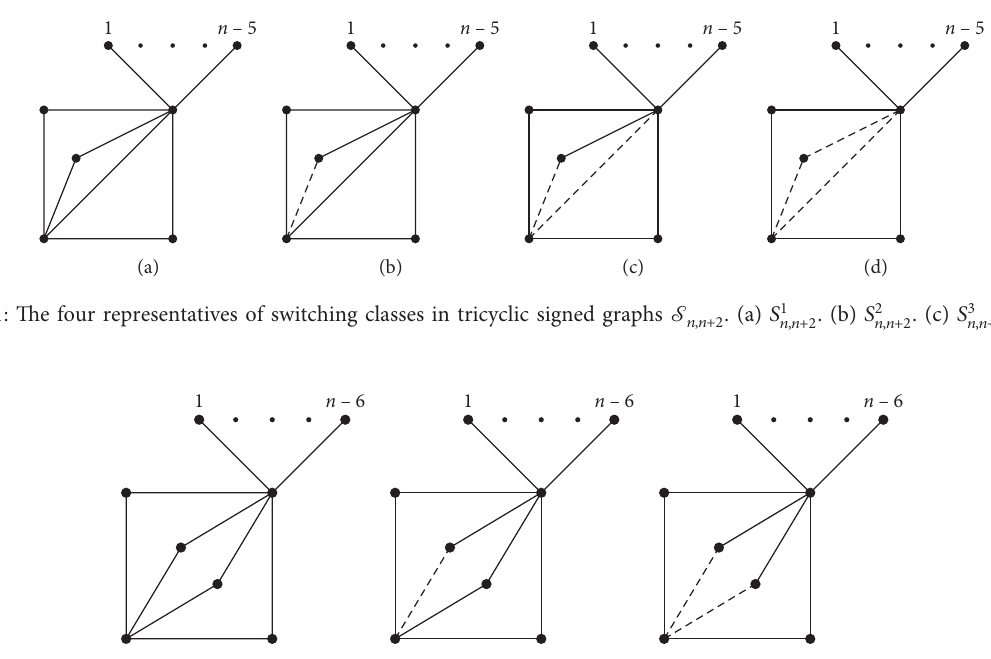
. (b) K 2 . (c) K 3 2 ,n − 2 2 ,n − 2 2 ,n − 2